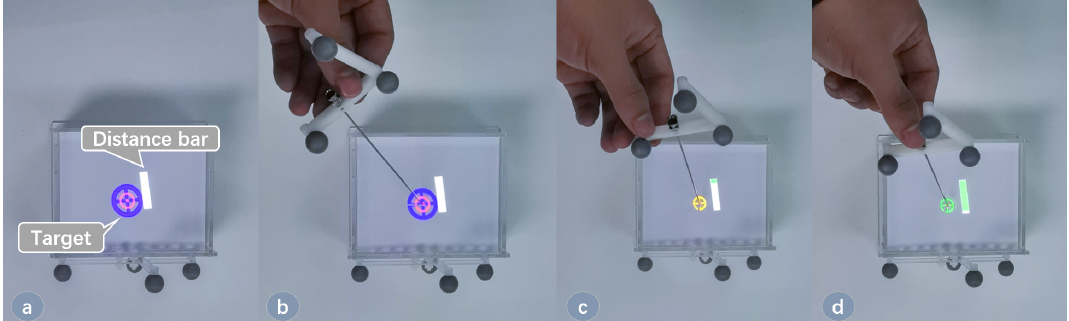
Figure 9. The augmented view for puncture. ( a ) Project the circles on the surface; ( b ) Align the needle’s tip to the center of the circle; ( c ) Adjust the direction of the needle to the circle turning yellow; ( d ) Start the puncture, and when the target turns green, it means that the needle has reached the